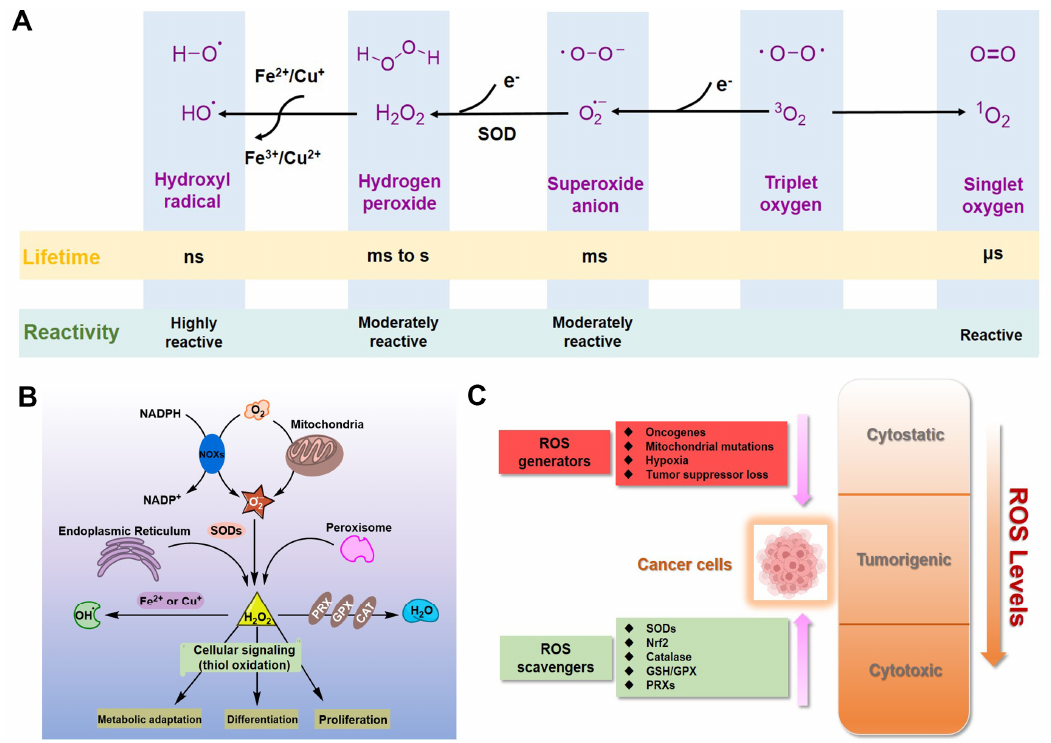
Figure 1. ROS in cancer cells. ( A ) Generation and chemical structures of ROS. ( B ) Brief metabolic process and signal regulation of intracellular ROS. ( C ) Balancing ROS generation and scavenging in cancer cells to remain in the tumorigenic range.